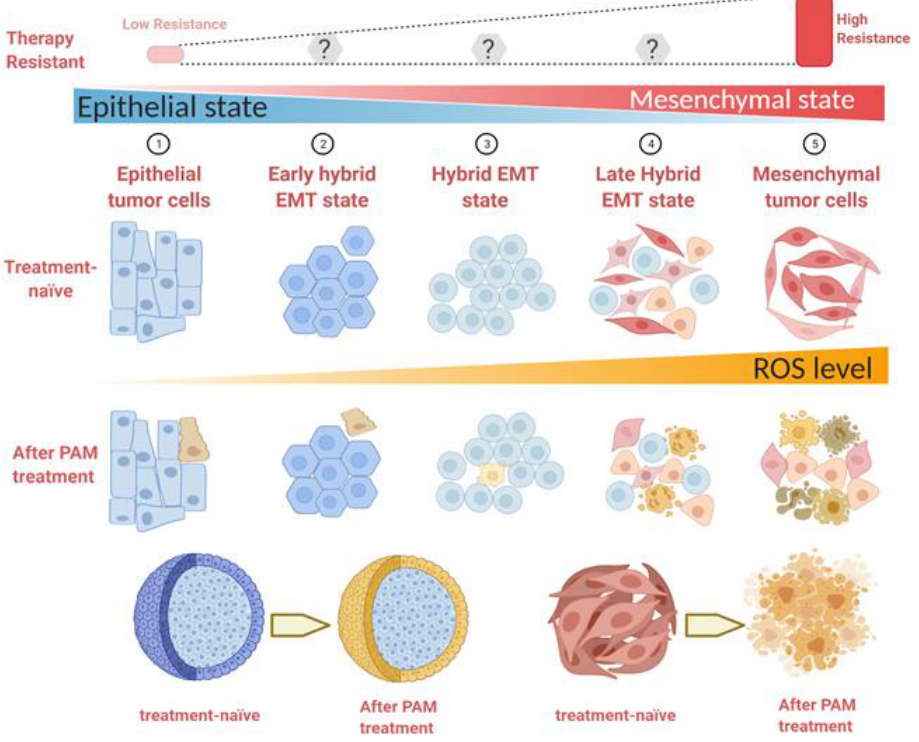
Figure 8. Schematic illustration of the relationship between EMT status, resistance to conventional therapies, responses to PAM, and ROS levels. Created with BioRender.com (accessed on 14 April 2021).